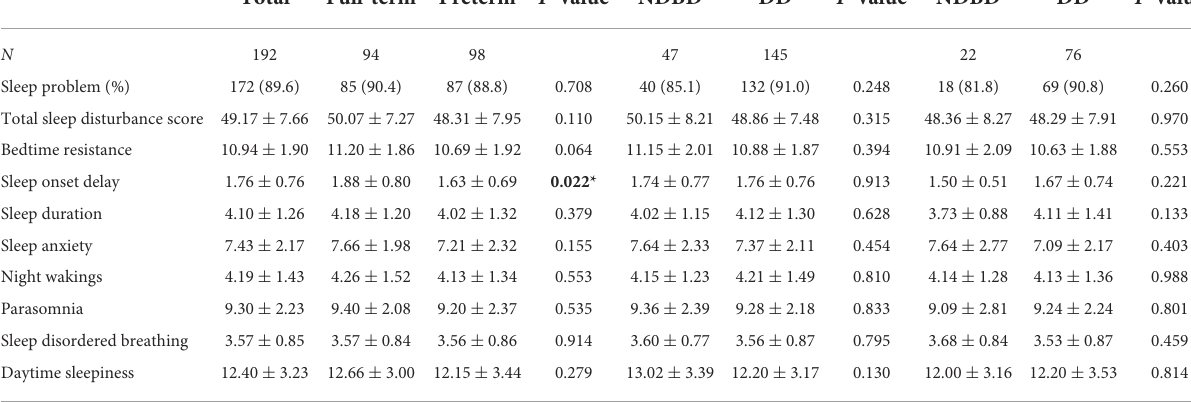
TABLE 2 CSHQ scores of the subjects.